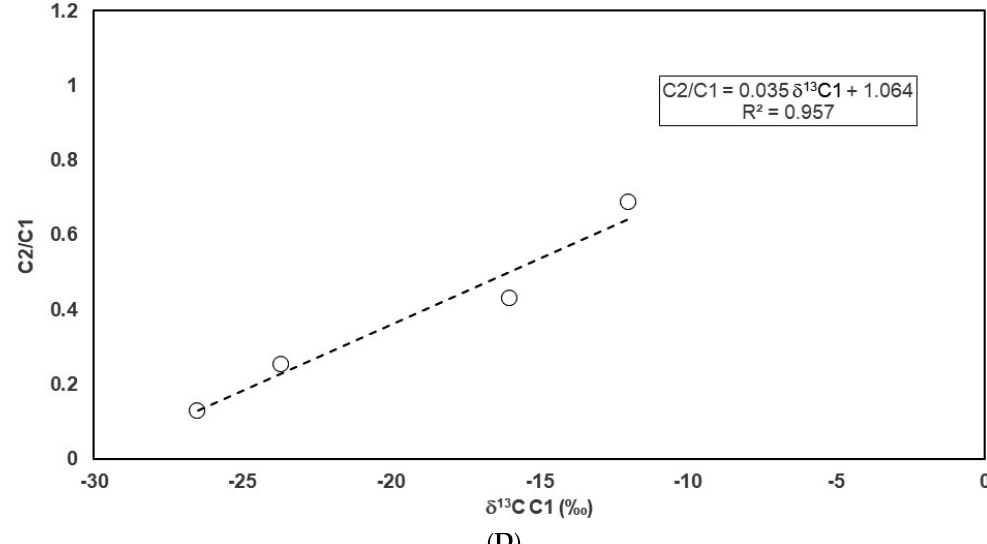
Figure 5. ( A ) Plot of methane C/C 0 ratio versus δ 13 C1. Initial C 0 concentration corresponds with the initial methane content of the model gas composition No.1; ( B ) Plot of ethane C/C 0 ratio versus δ 13 C2. Initial C 0 concentration originates from the initial ethane content of the model gas mixture No.1; ( C ) Diagram C2/C1 versus δ 13 C1 according to [24]. Plot corresponds to linear mixing rather than diffusion loss. Possible two mixing members have δ 13 C1 − 30 and − 5‰ (Ostrava Formation—subset B); ( D ) Diagram C2/C1 versus δ 13 C2. Linear mixing is not positive, significant loss of methane overlap possible relationship (subset B).